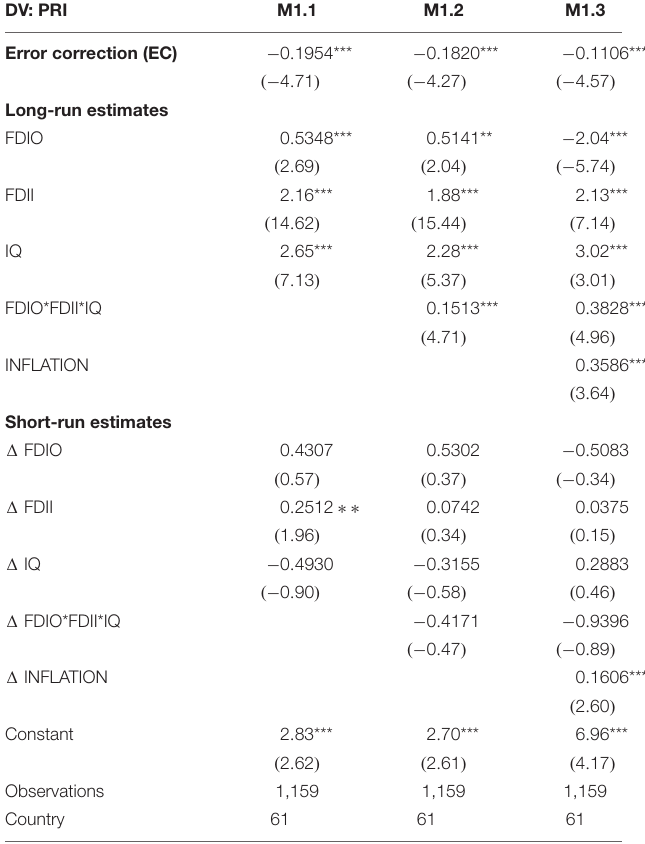
TABLE 7 | The impact of FDII, FDIO, and IQ on